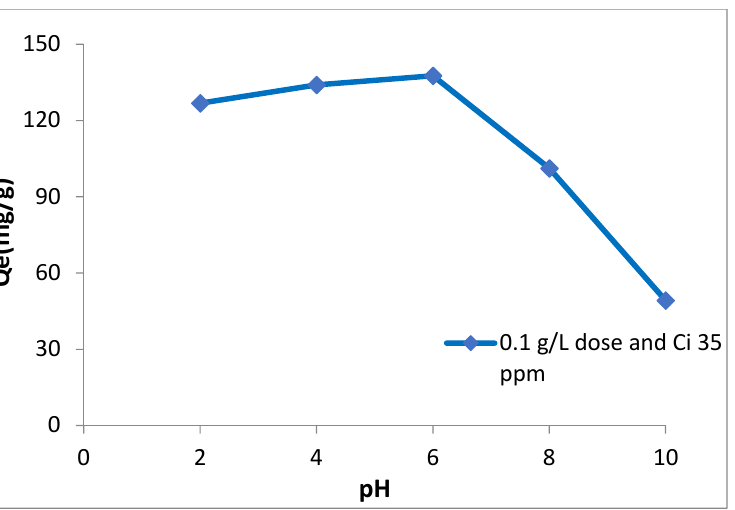
Figure 5. Effect of solution pH on As (III) adsorption by Fe (III)-Mg (II) binary metal oxide nanomaterial at initial As concentration of 35 mg/L and adsorbent dosage 0.1 g/L. Both As(III) and As(V) exist as negatively charged species such as HAsO 42 − , AsO 43 − ,